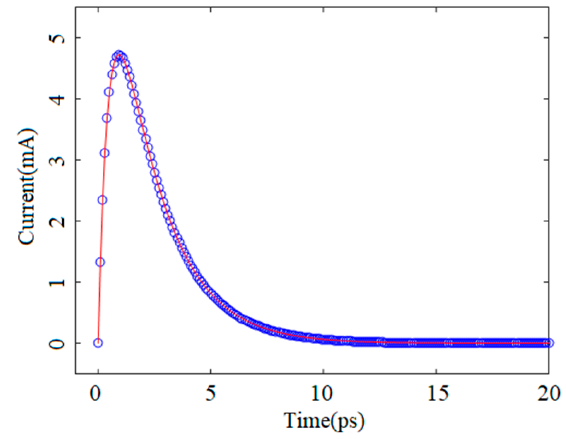
Figure 9. The current waveform used to simulate SET in this paper.